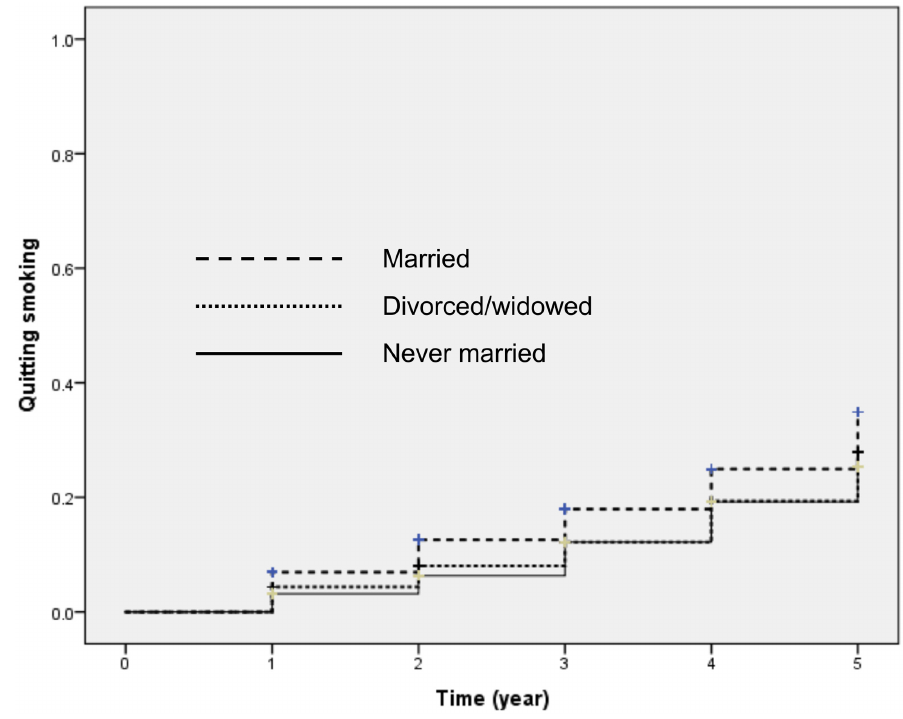
Fig 2. Kaplan-Meier curves for smoking cessation by marital status (p < 0.01, log-rank test).